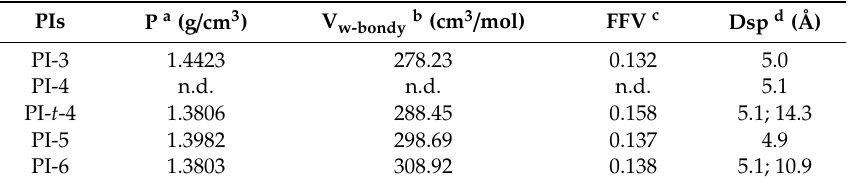
Table 2. Density, fractional free volume, and d